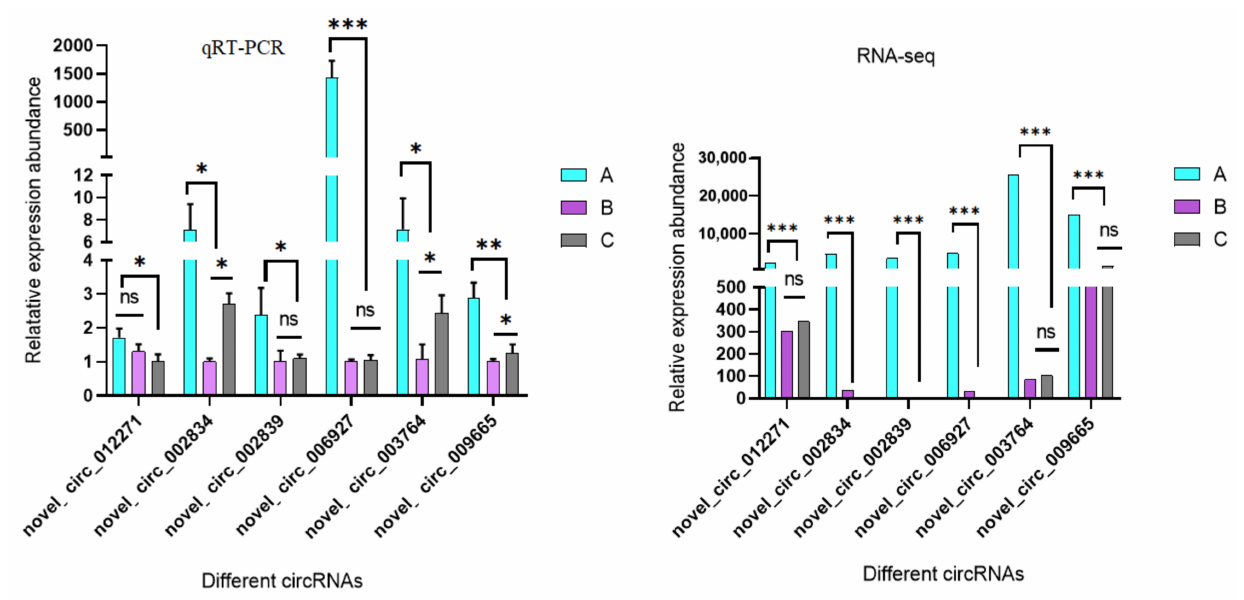
Figure 9. qRT-PCR validation of the differential expressed circRNAs. * indicates p < 0.05, ** indicates p < 0.01, *** indicates p < 0.001, ns indicates there is no significant